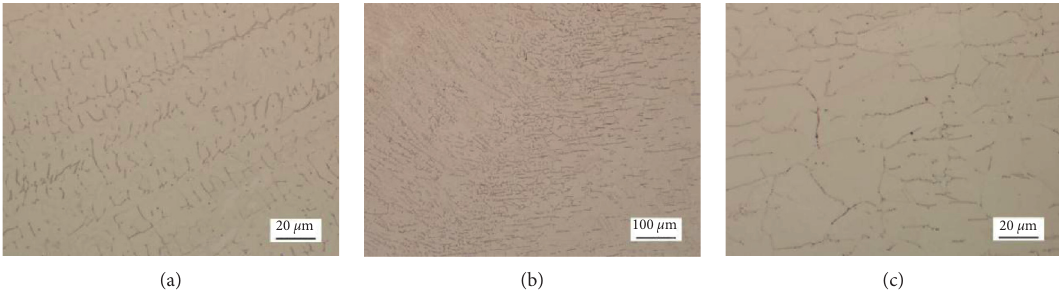
Figure 5: Microstructure of welded joint with shielding gas of 98%Ar +2%N